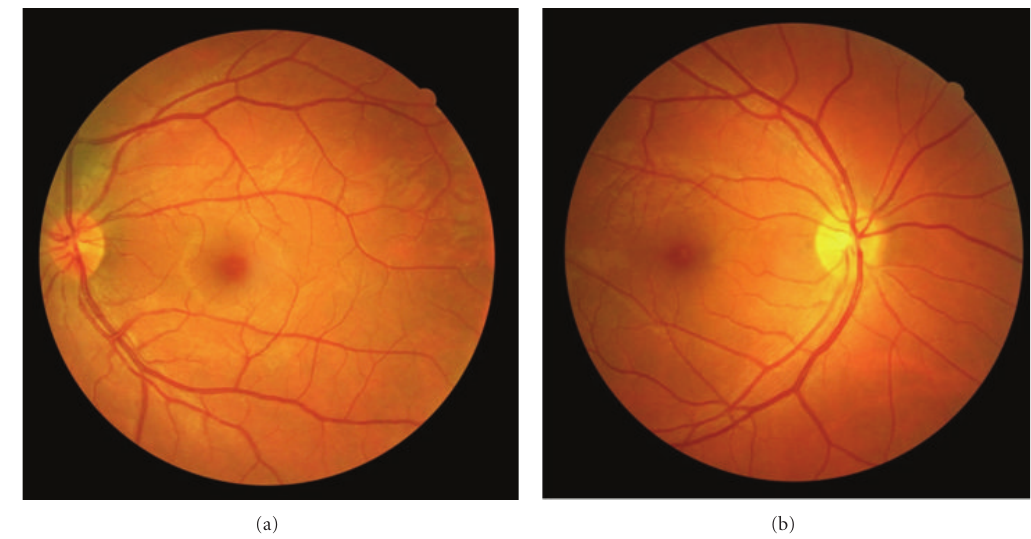
Figure 3: Fundus photographes of both eyes, one month after cataract surgery of the second eye. (a) Left eye. (b) Right